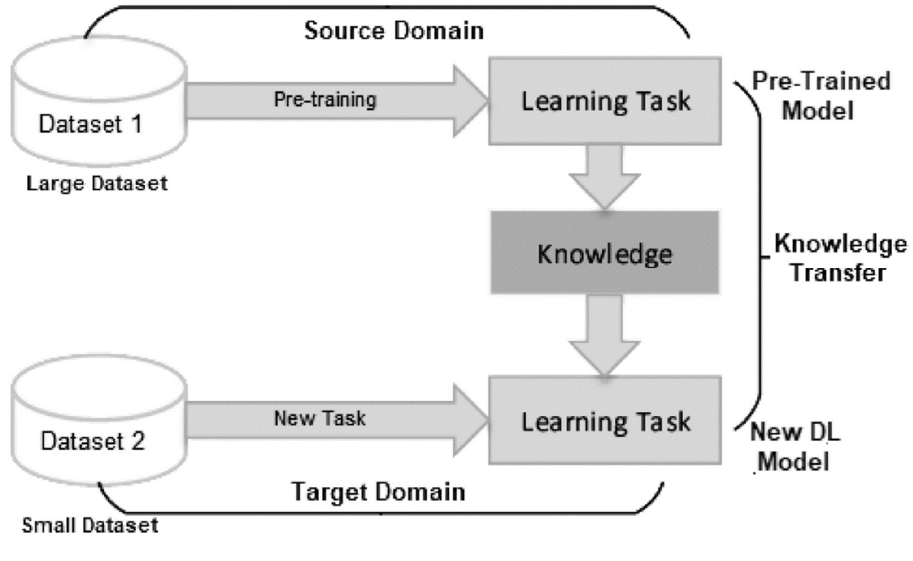
Figure 10. Transfer learning structure. DL: deep learning [34].